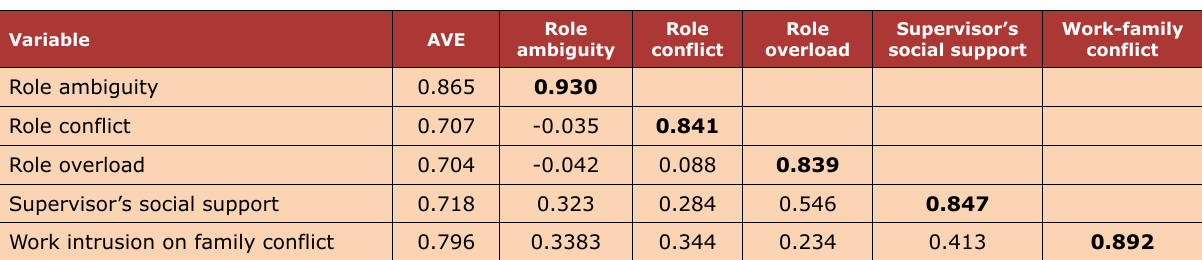
Table 2. The results of convergent and discriminant validity analyses